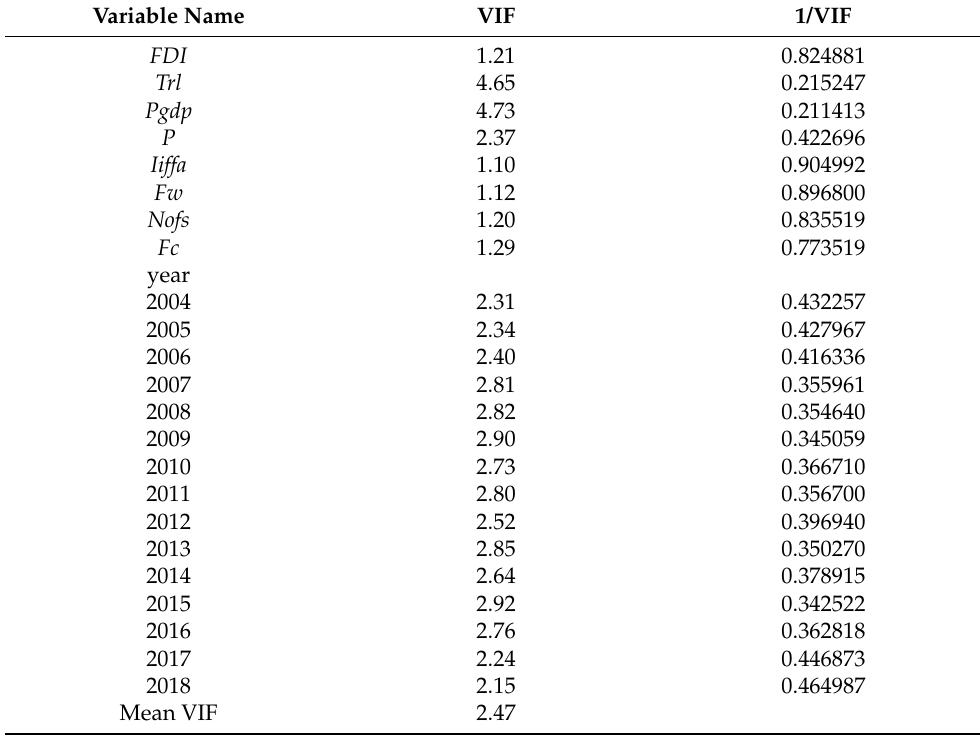
Table 5. Sample multicollinearity